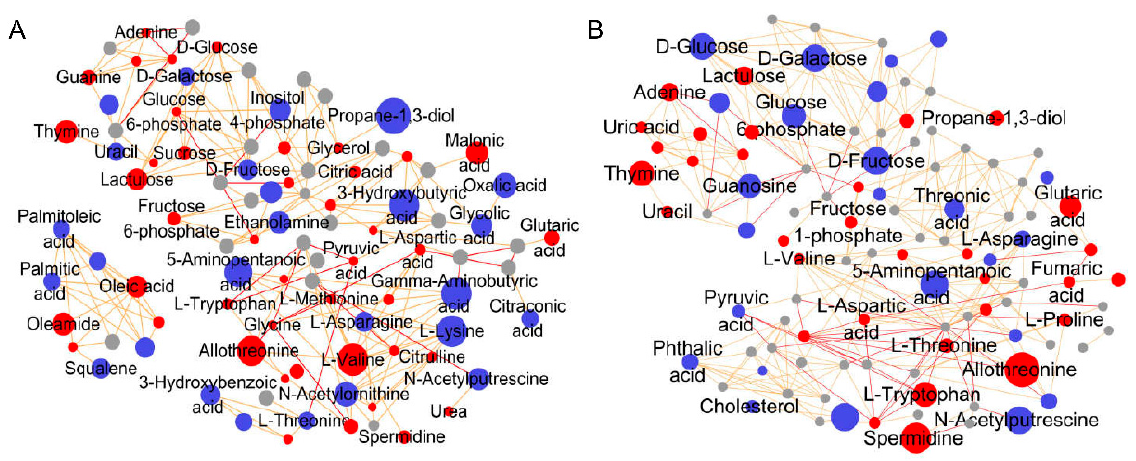
Figure 7. Metabolic pathway network map of A549 cells treated with ( A ) PQ and ( B ) Del. Blue, red, and gray colors represented the downregulated, upregulated and unaffected metabolites, respec- tively.